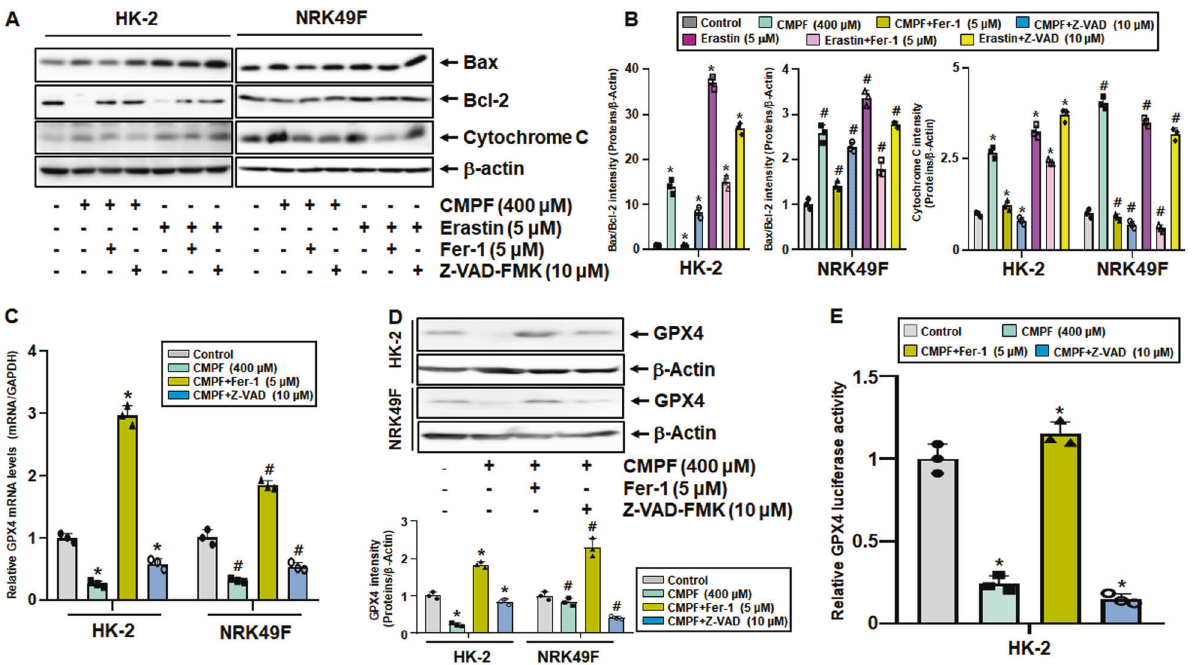
Fig. 8 Regulation of GPX4 and apoptosis-related protein expression by CMPF, Erastin, Fer-1, and Z-VAD-FMK treatment in HK-2 and NRK49F cells. HK-2 and NRK49F cells were harvested treatment with 400 μ M of CMPF or 5 μ M erastin for 24 h under serum starvation. The cells were pretreated with ferroptosis inhibitor (Fer-1, 5 μΜ ) or multi-caspase inhibitor Z-VAD-FMK (10 μ M)1 h before CMPF or elastin treatment. ( A ) Expression levels of Bax, Bcl-2, and cytochrome C proteins as detected by immunoblotting. ( B ) Relative protein levels. ( C ) The mRNA levels of genes indicated, as measured by qRT-PCR. The values for control group are set to 1. ( D ) Expression levels of GPX4 protein in cells treated with 400 μ M CMPF after pretreatment with 5 μ M Fer-1 and 10 μ M Z-VAD-FMK for 1 h, as measured by immunoblotting. The lower bar graph shows the relative protein levels. ( E ) GPX4 promoter activity in cells treated with 400 μ M CMPF after pretreatment with 5 μ M Fer-1 and 10 μ M Z-VAD-FMK for 1 h, as determined by luciferase activity using a luminometer. Luciferase activity levels in the fi re fl y/renilla control samples were set as 1. All values are presented as the mean ± SD. Statistical signi fi cance was measured using Kruskal-Wallis test followed by Dunn ’ s post hoc test. *, P < 0.05, compared with the HK-2 control. # , p < 0.05, compared with the NRK49F control.